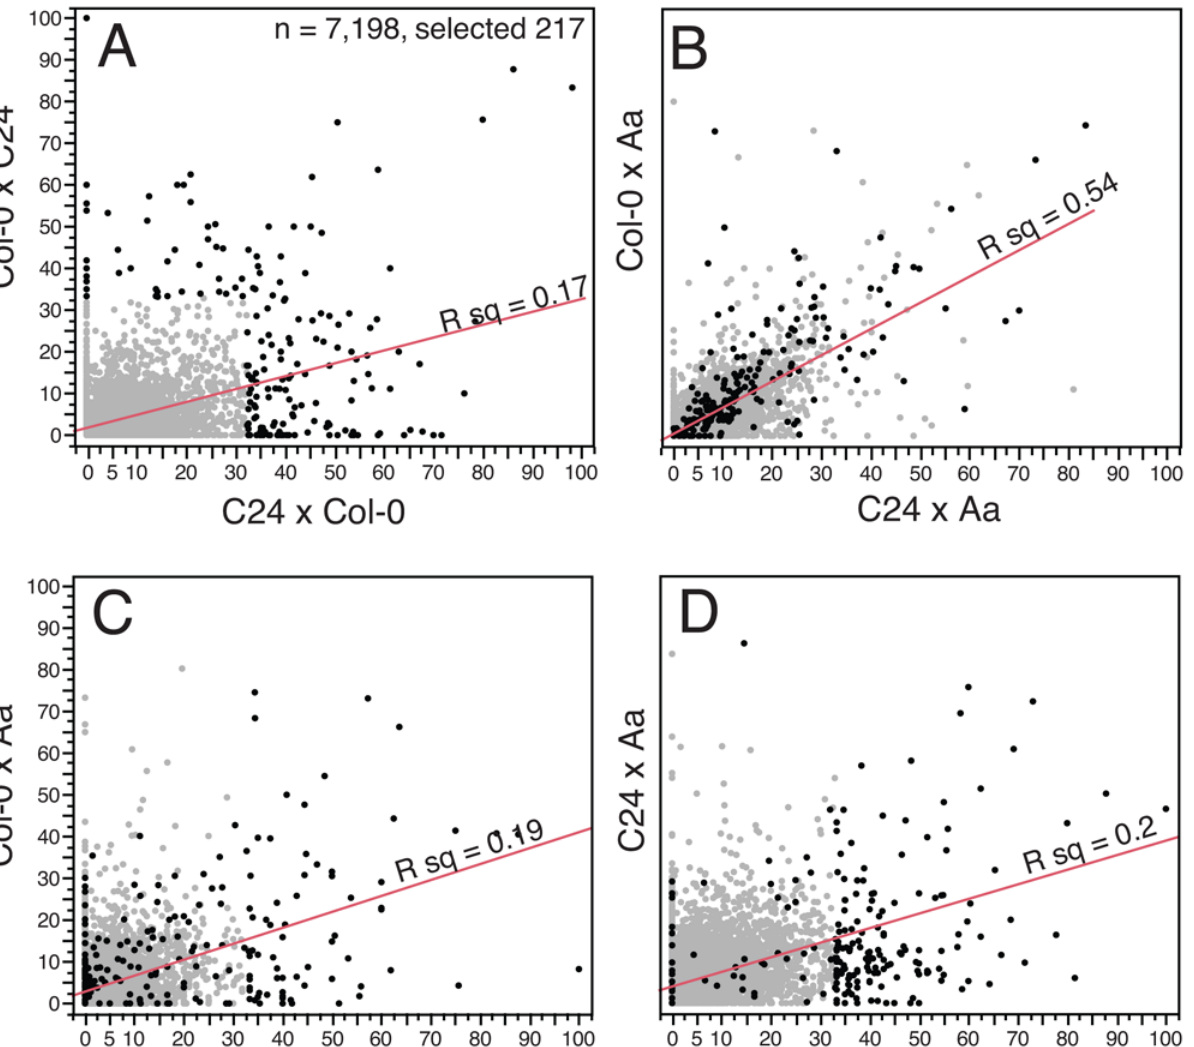
Fig 3. Paternal bias is most correlated in crosses sharing the same pollen parent. Fraction of paternal transcript for each gene crossing a threshold of minimum mean expression in all of the four studied crosses. Most genes are significantly parentally biased in at least one cross. The linear regression lines are shown. A . Paternal bias is poorly correlated in reciprocal intraspecific crosses of A . thaliana accessions Col and C24. Genes that exceed 33% paternal bias are highlighted in black and their position can be compared in plot B, C and D. B . Higher correlation in interspecific hybrids formed by pollination of A . thaliana by the same accession of A . arenosa . C,D . Sharing the same seed parent does not increase correlation of paternal